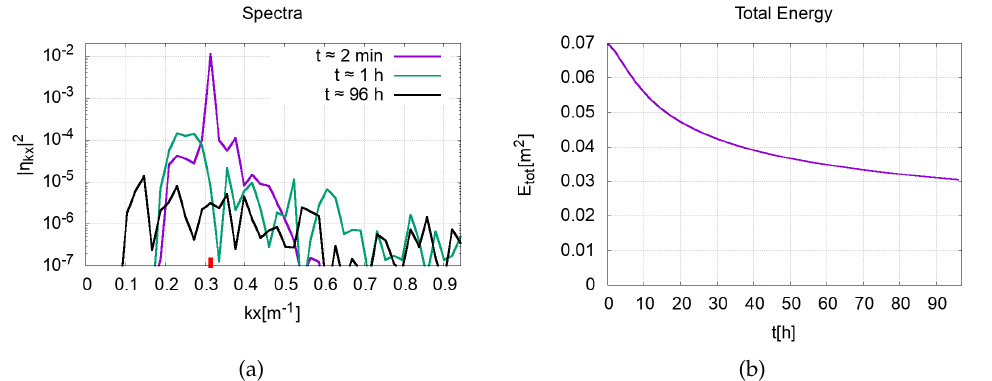
Figure 3. Panel ( a ) shows the evolution of one-dimensional spectrum | η ( k x , k y = 0, t ) | 2 overtime in logarithmic scale. A small red line indicates the initial characteristic wavenumber k x 0 . Purple curve corresponds to the almost initial spectrum at time t ≈ 2 min, green curve corresponds to the spectrum at time t ≈ 1 h, and the black one corresponds to the spectrum at time t ≈ 96 h. Panel ( b ) shows the total energy dependence in time.